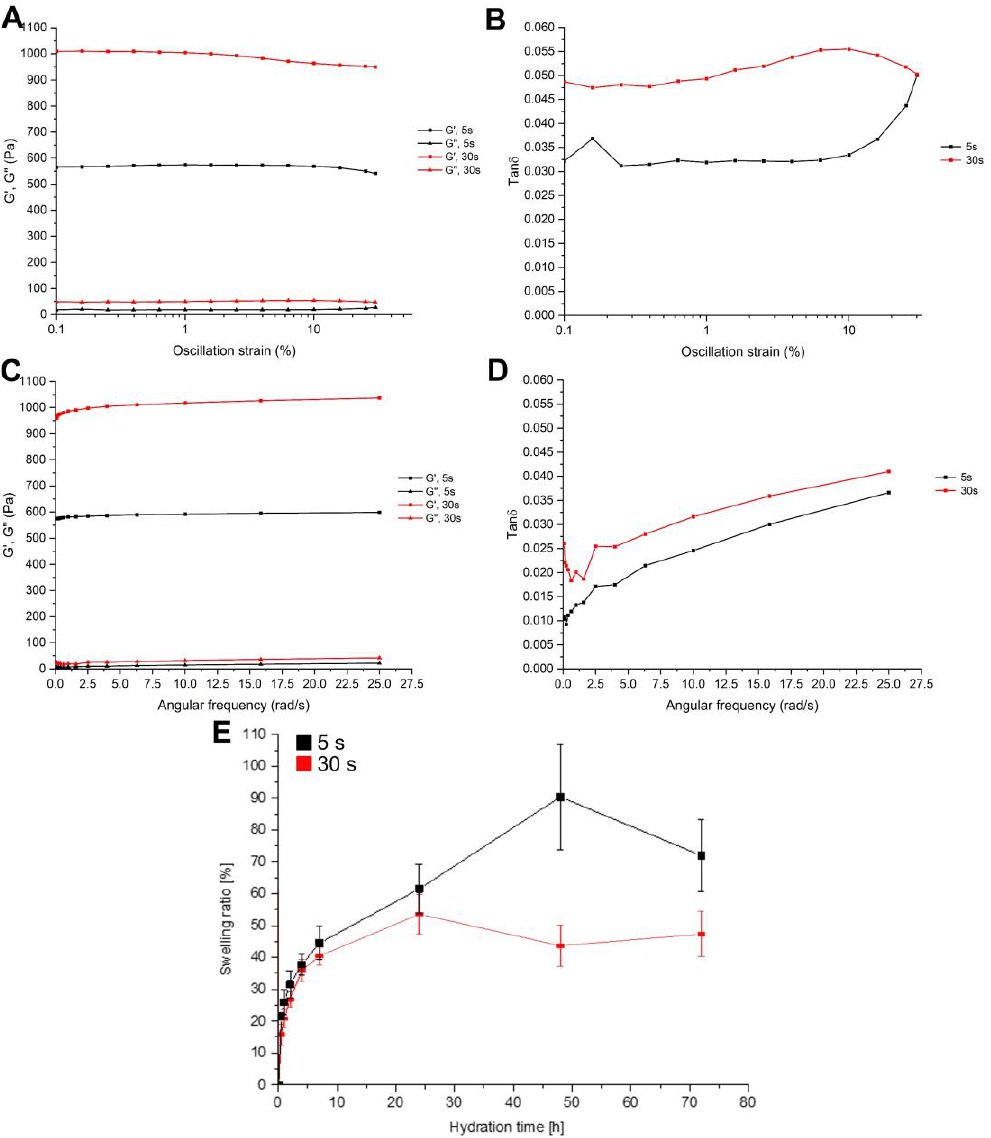
Figure 2. ( A ) Storage ( G’ ) and loss ( G’’ ) moduli reported in the function of the oscillation strain (in log scale); all the curve results were linear up to 1%. ( B ) Tan δ in the functioning of the oscillation strain; the trend for the 5 s crosslinked material was different from the other due to the incomplete crosslinking. ( C ) G’ and G’’ in the functioning of the angular frequency at a constant strain of 1%. ( D ) Tan δ in the functioning of the angular frequency with a constant strain of 1%. ( E ) Swelling ratio during 72 h with different exposure times (5 s and 30 s); as expected, the less exposed samples tend to sell faster, reaching a higher amount of incorporated water.